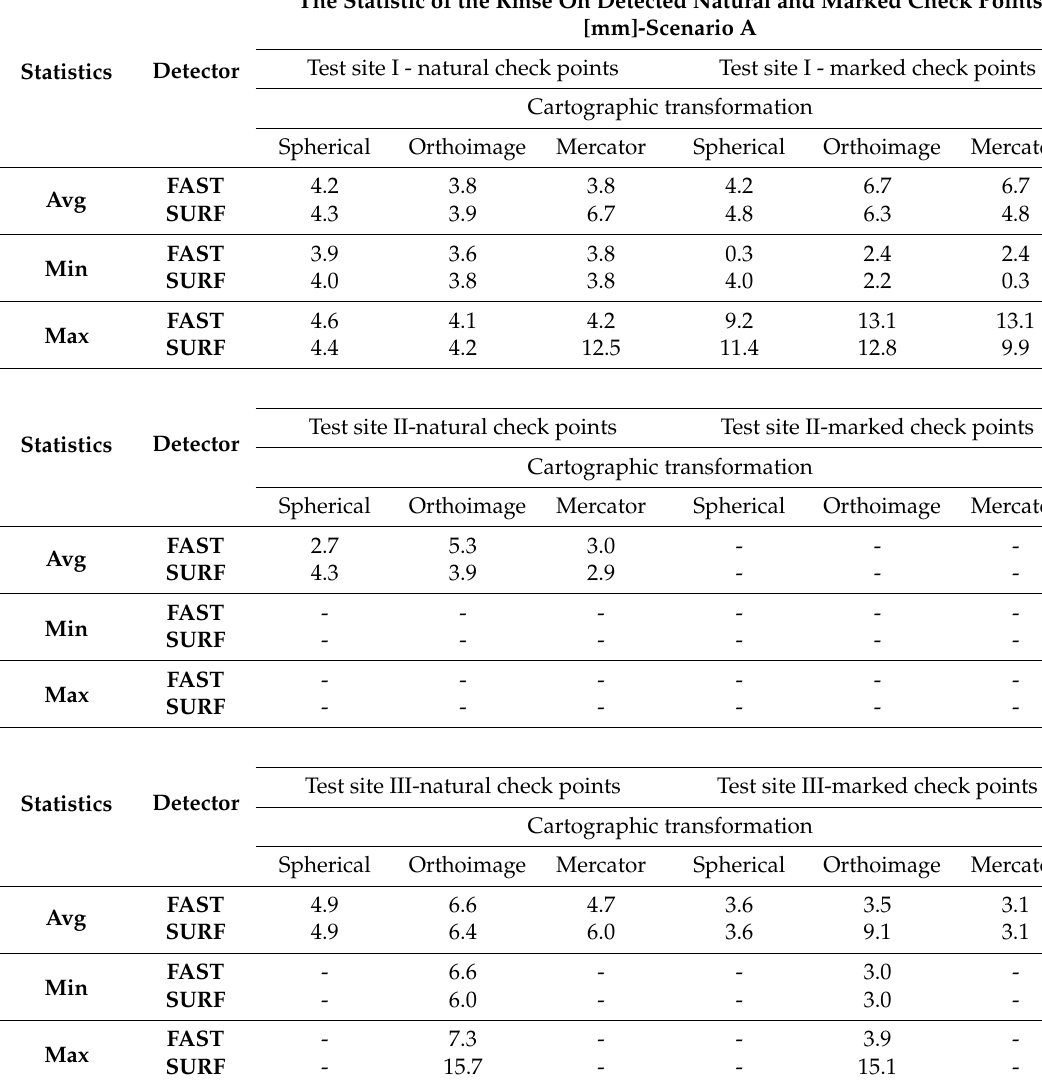
Table 10. The statistics of the RMSE values on natural and marked check points for all test sites (scenario